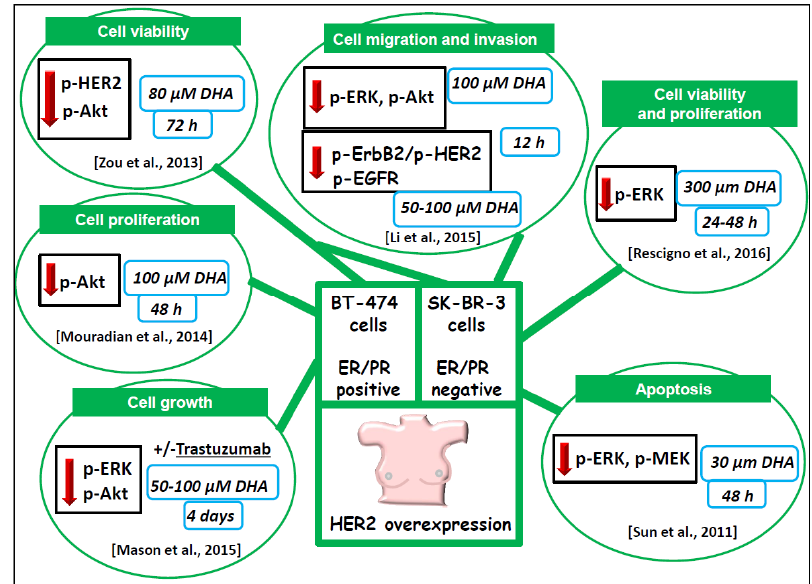
Figure 4. Outline of the main results of the in vitro reports investigating LCn-3 PUFA regulation of ERK and AKT and their upstream components in the ERK and phosphoinositide survival pathways in BT-474 and SK-BR-3 breast cancer cells. The green labels show the main features, functions, or cellular processes that are related to cell growth and regulated in an antineoplastic sense by LCn-3 PUFA in these breast cancer cells. The red arrows indicate negative regulation by LCn-3 PUFA. The light blue boxes illustrate the LCn-3 PUFA concentrations used and the length of the incubations with fatty acids.